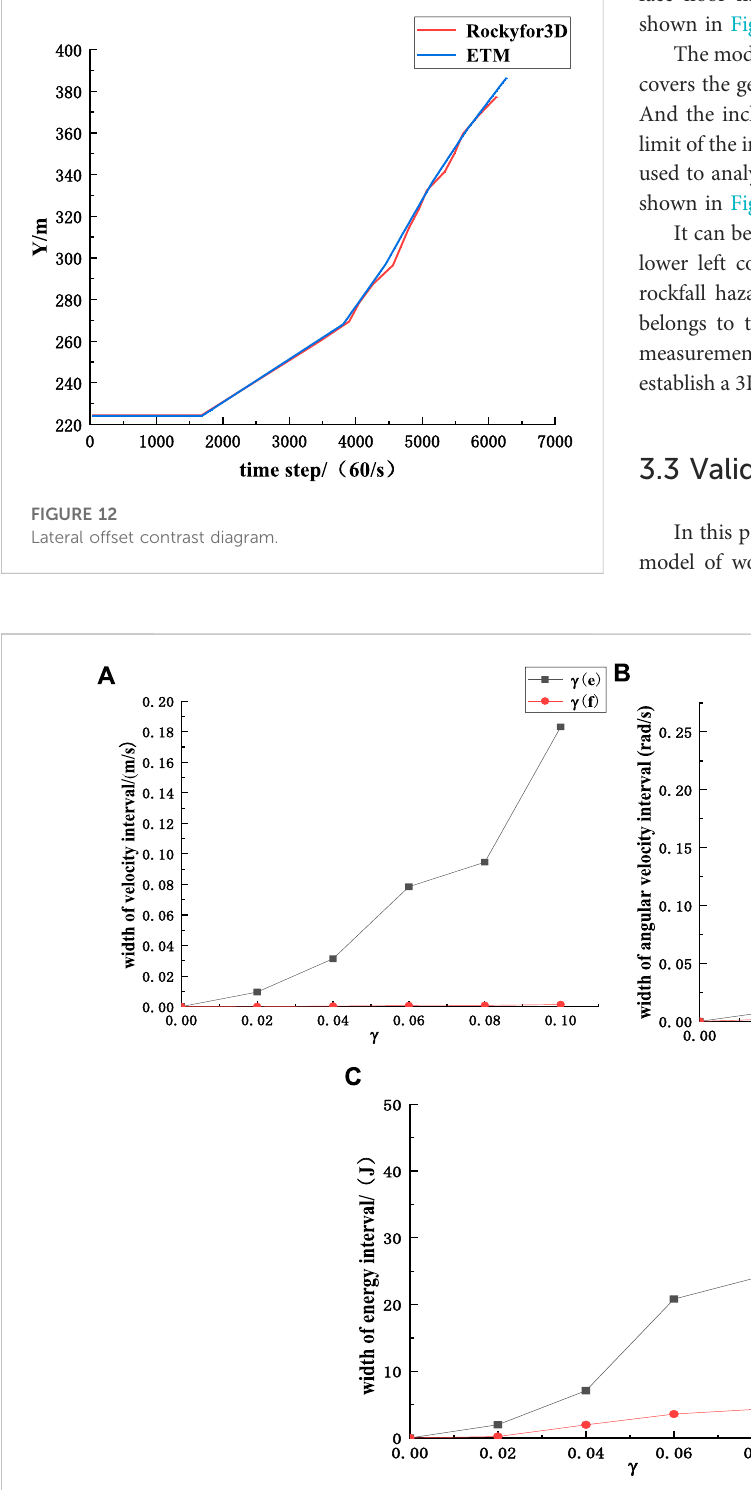
Frontiers in Earth